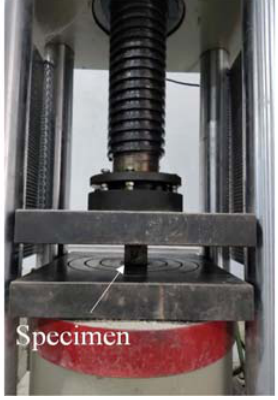
Figure 3. Diagram of compressive test.